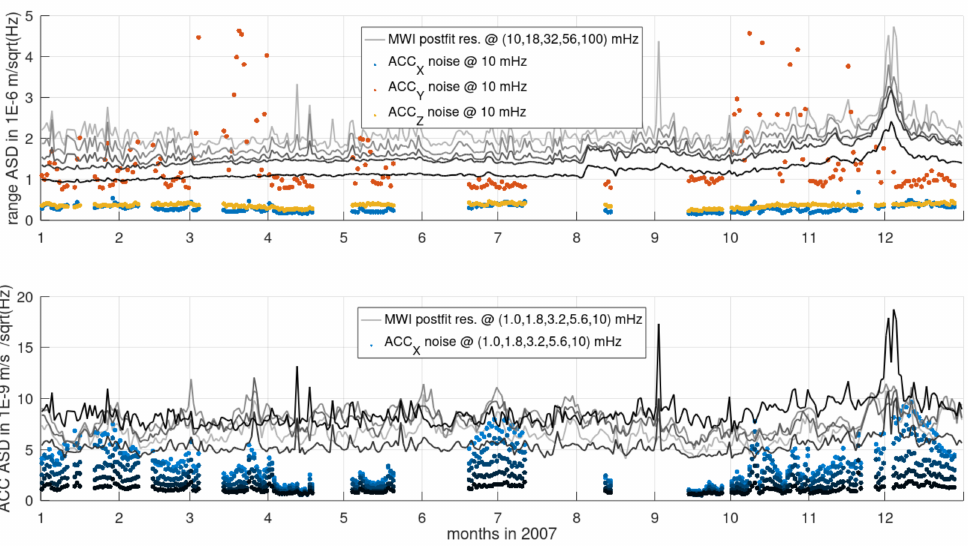
Figure 5. Smoothed ASD values for range rate post-fit residuals (gray) and ACC noise (colored) for 2007 for different frequency bands. ( Top ) High frequencies (between 10 and 100 mHz) in terms of ranges comparing the range rate post-fit residuals with the three ACC axes for 10 mHz. ( Bottom ) medium frequencies (between 1 and 10 mHz) in terms of accelerations comparing the range rate post-fit residuals with the X-axis ACC